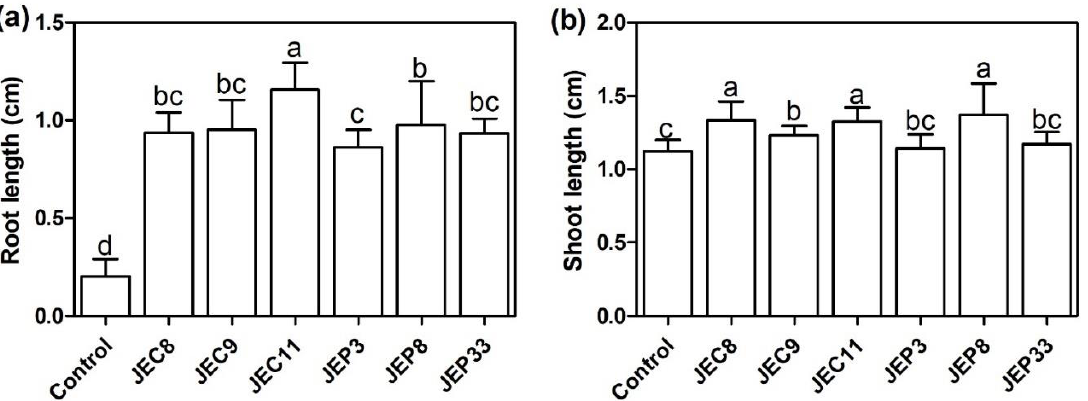
Figure 3. Effect of Pb- and Cd-tolerant bacterial strains on T. latifolia . T. latifolia seeds were mixed with bacterial suspensions and incubated in water-agar 0.7% (w/v) for 10 days. ( a ) Root length and ( b ) shoot length after incubation. Data represent the mean ± SD. Different letters indicate significant differences between treatments ( p < 0.05).